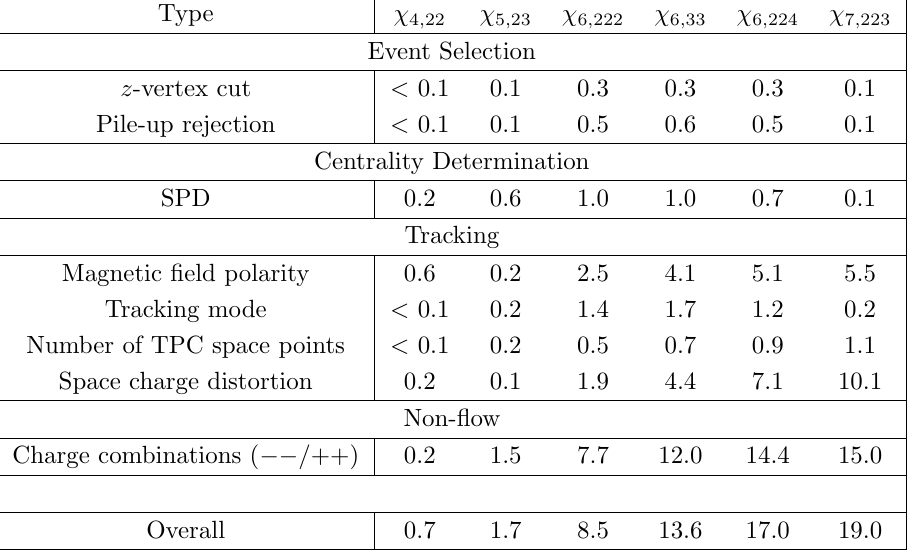
Table 4 . Relative systematic uncertainties of the non-linear (cid:13)ow mode coe(cid:14)cients (cid:31) n;mk .